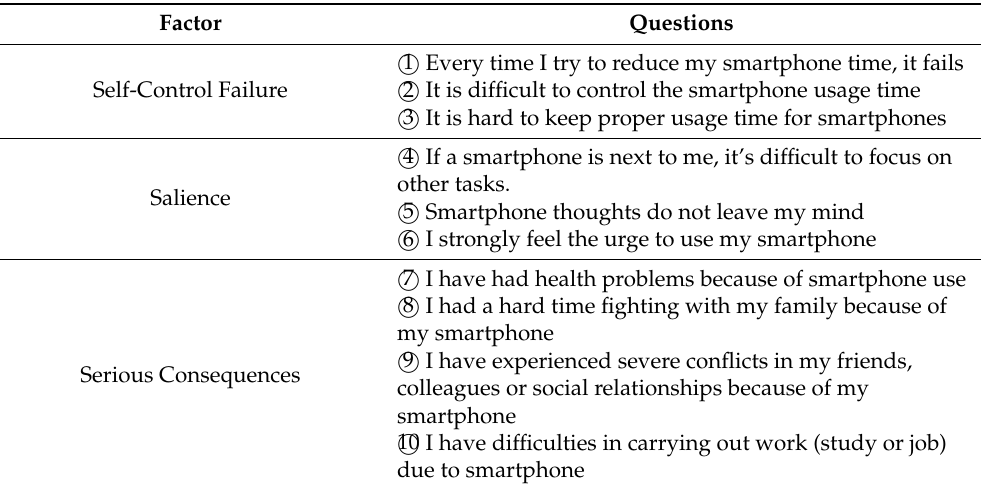
Table 1. Components of the smartphone addiction scale for Korean adolescents.